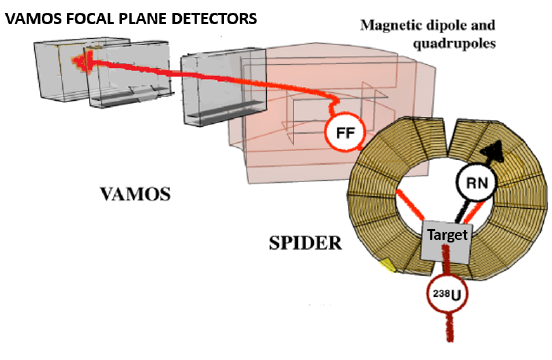
Figure 1. Sketch of the VAMOS + SPIDER experimental setup.